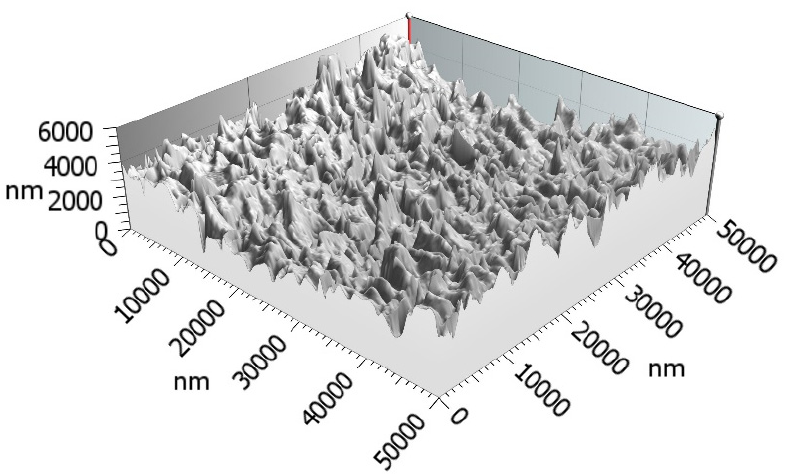
Figure 8. 3D image of the piezoresistive film surface, with vertical and lateral scales of 6000 nm and 50,000 nm (6 and 50 µ m),